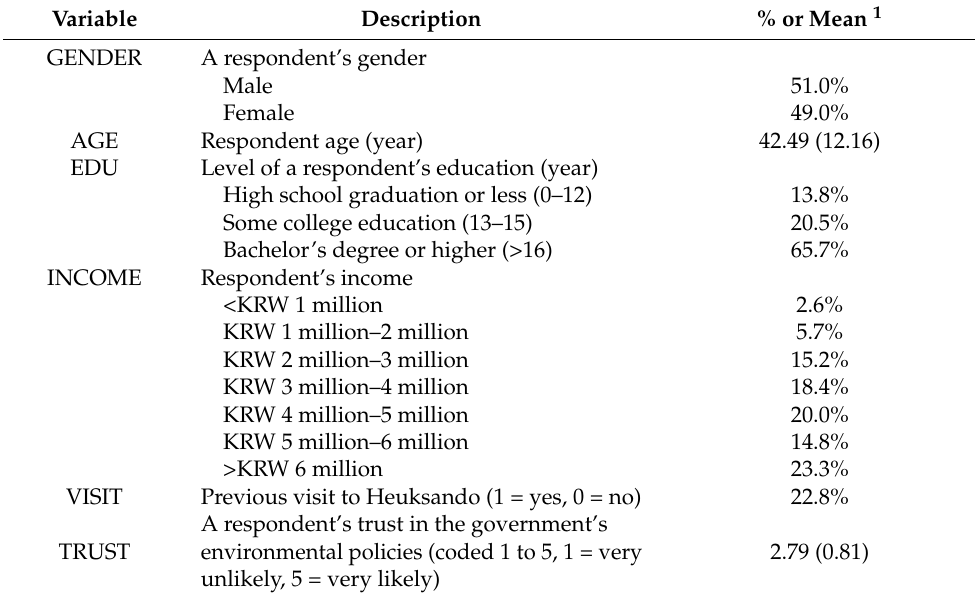
Table 2. Descriptive statistics of explanatory